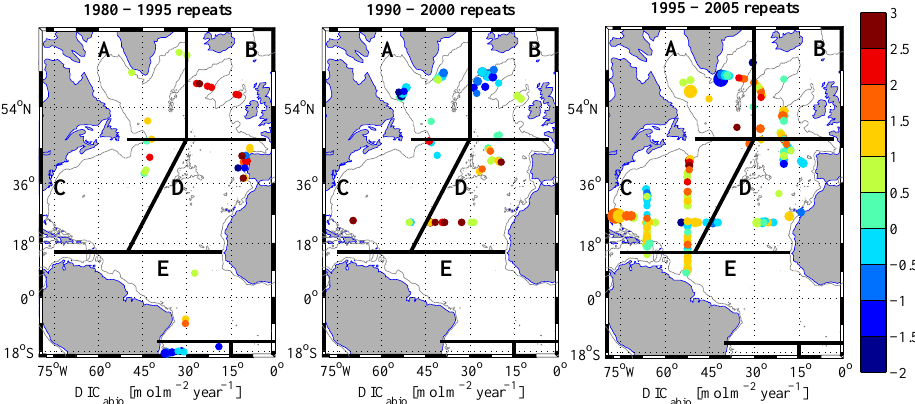
Fig. 8. Same as Fig. 7 but for storage rates (molm − 2 a − 1 ) of DIC abio .